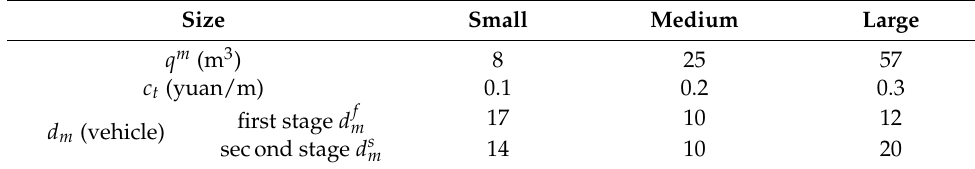
Table 7. Other parameters.